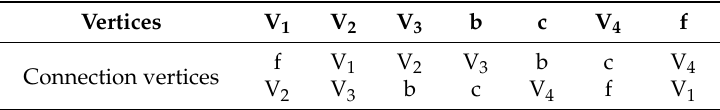
Table 2. Vertex connection list of facet 11.